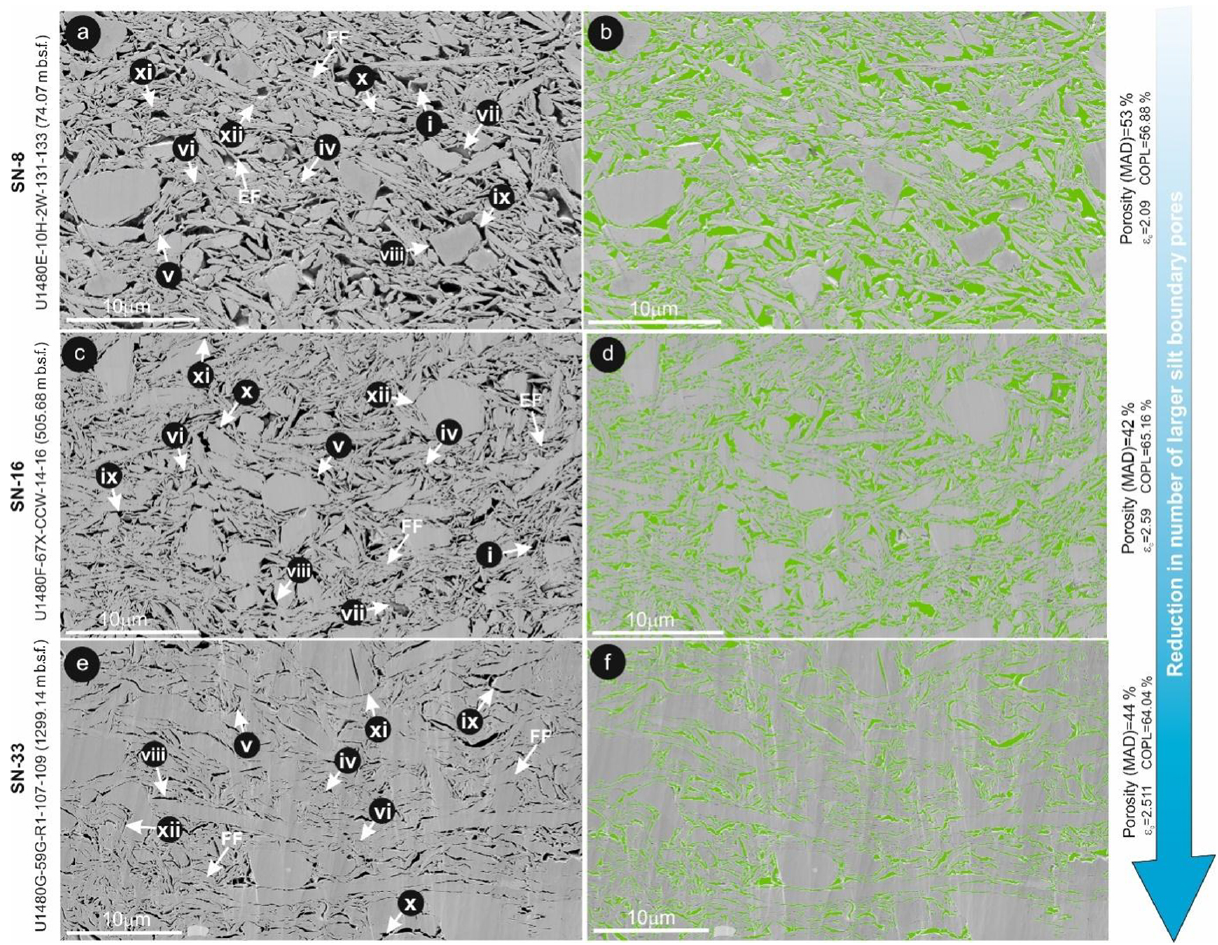
Figure 6. Microstructural overview (BIB–SEM) of samples SN-8 ( a and b ), SN-16 ( c and d ), and SN-33 ( e and f ). Green represents segmented pores of the corresponding microstructure of the sample. (i) Equant large clay-domain pores, (ii) elongated large clay-domain pores, (iii) crescent-shaped large clay-domain pores, (iv) equant small clay-domain pores, (v) crescent-shaped small clay-domain pores, (vi) elongated small clay-domain pores, (vii) equant large silt-adjacent pores, (viii) elongated large silt-adjacent pores, (ix) crescent-shaped large silt-adjacent pores, (x) equant small silt-adjacent pores, (xi) crescent-shaped small silt-adjacent pores, (xii) elongated small silt-adjacent pores. FF: face-to-face contact, EF: edge-to-face